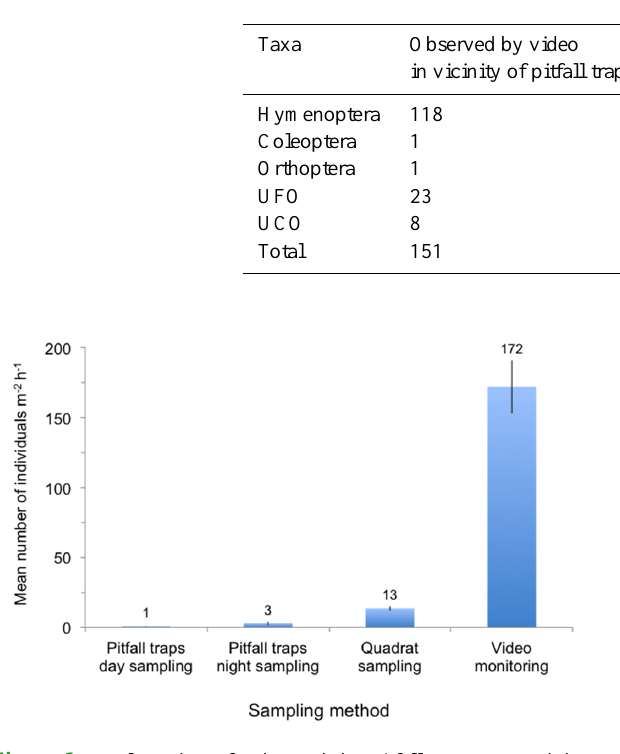
Figure 1. Total number of arthropods by pitfall traps exposed dur- ing the day, pitfall traps exposed during night, quadrat sampling and video monitoring. Mean ± SD pooled among measurement dates ( n = 5). Note: for methodological reasons areal basis does not ap- ply for pitfall trapping.